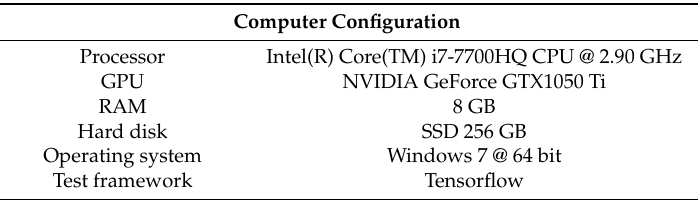
Table 1. The machine configuration used in experimental environment.